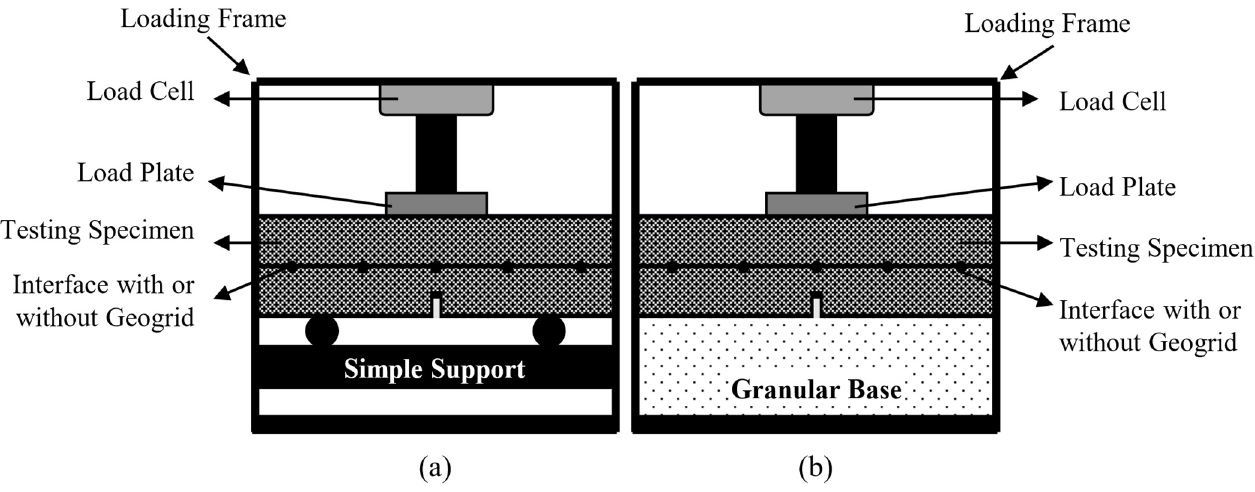
Figure 4. Loading application sketch of the two scenarios ( a ) with simple support, and ( b ) a granular base as a support.